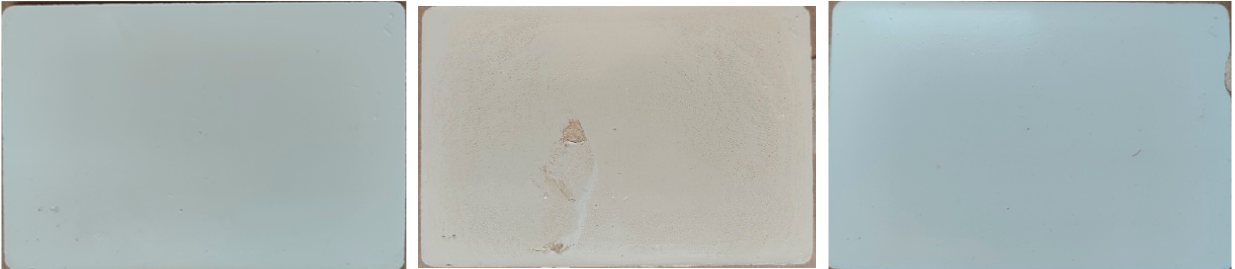
Figure 10. Plates of 5% ( left ) and 15% ( center ) of GP-B in RPUF-C formulations. Plate of 5% of GP-C in RPUF-C formulations ( right ).